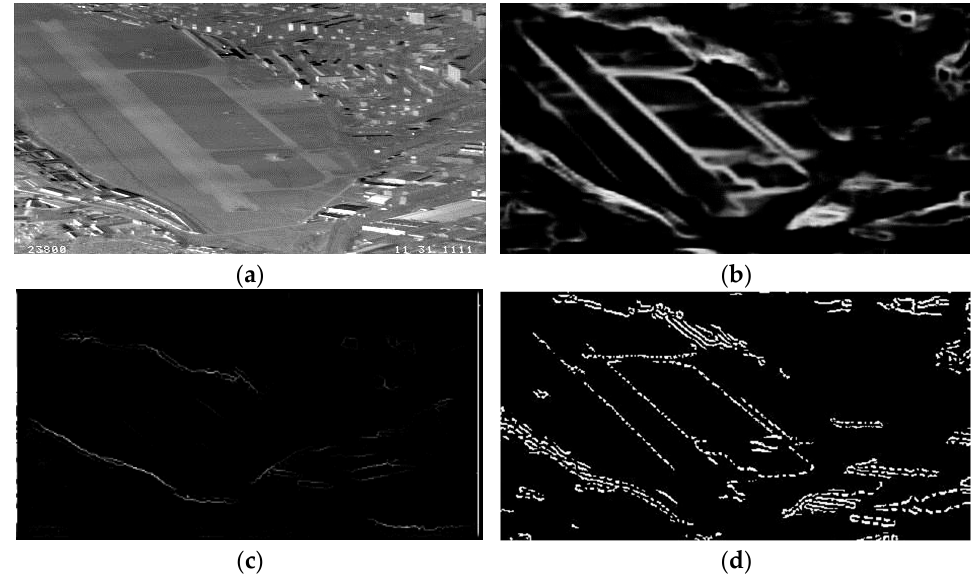
Figure 6. Infrared light edge detection results. ( a ) Original image; ( b ) improved HED network; ( c ) DeepContour; ( d ) the algorithm in this paper.